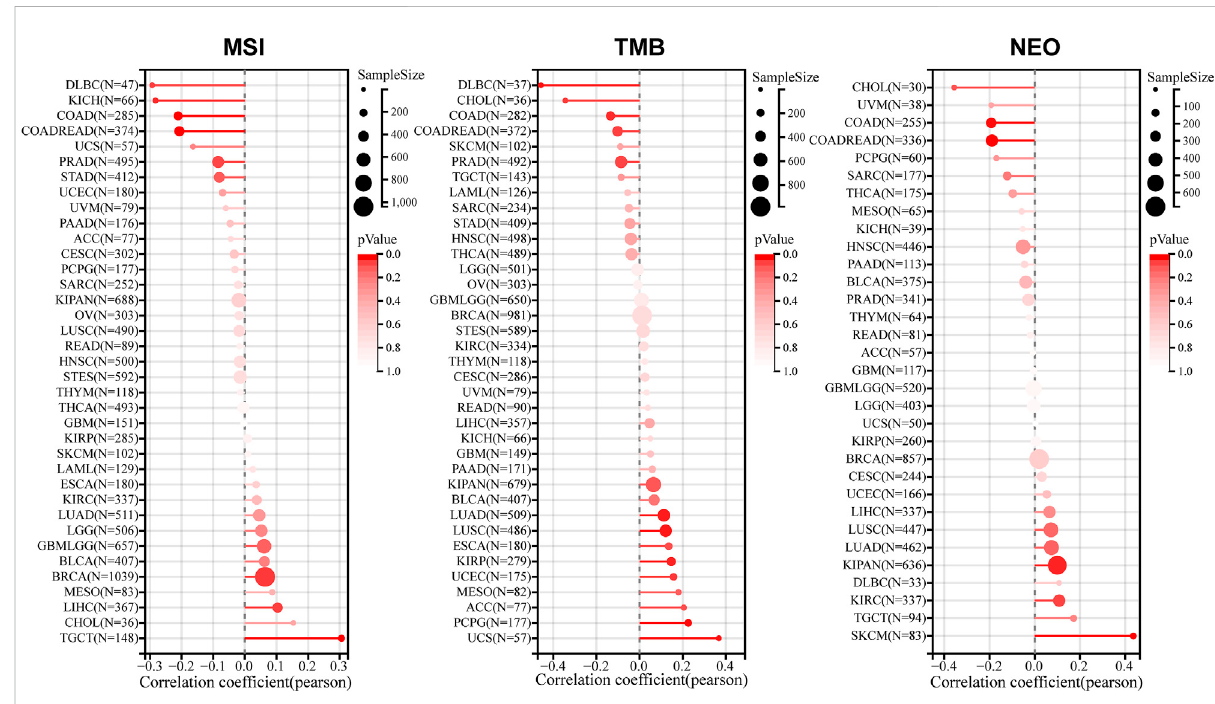
FIGURE 6 ThecorrelationbetweenLINC00857expressionandMSI,TMBorNEO.AstickchartdisplayedtheconnectionsbetweenLINC00857expression and MSI, TMB or NEO in diverse cancers via the Sangerbox 3.0 database (Pearson